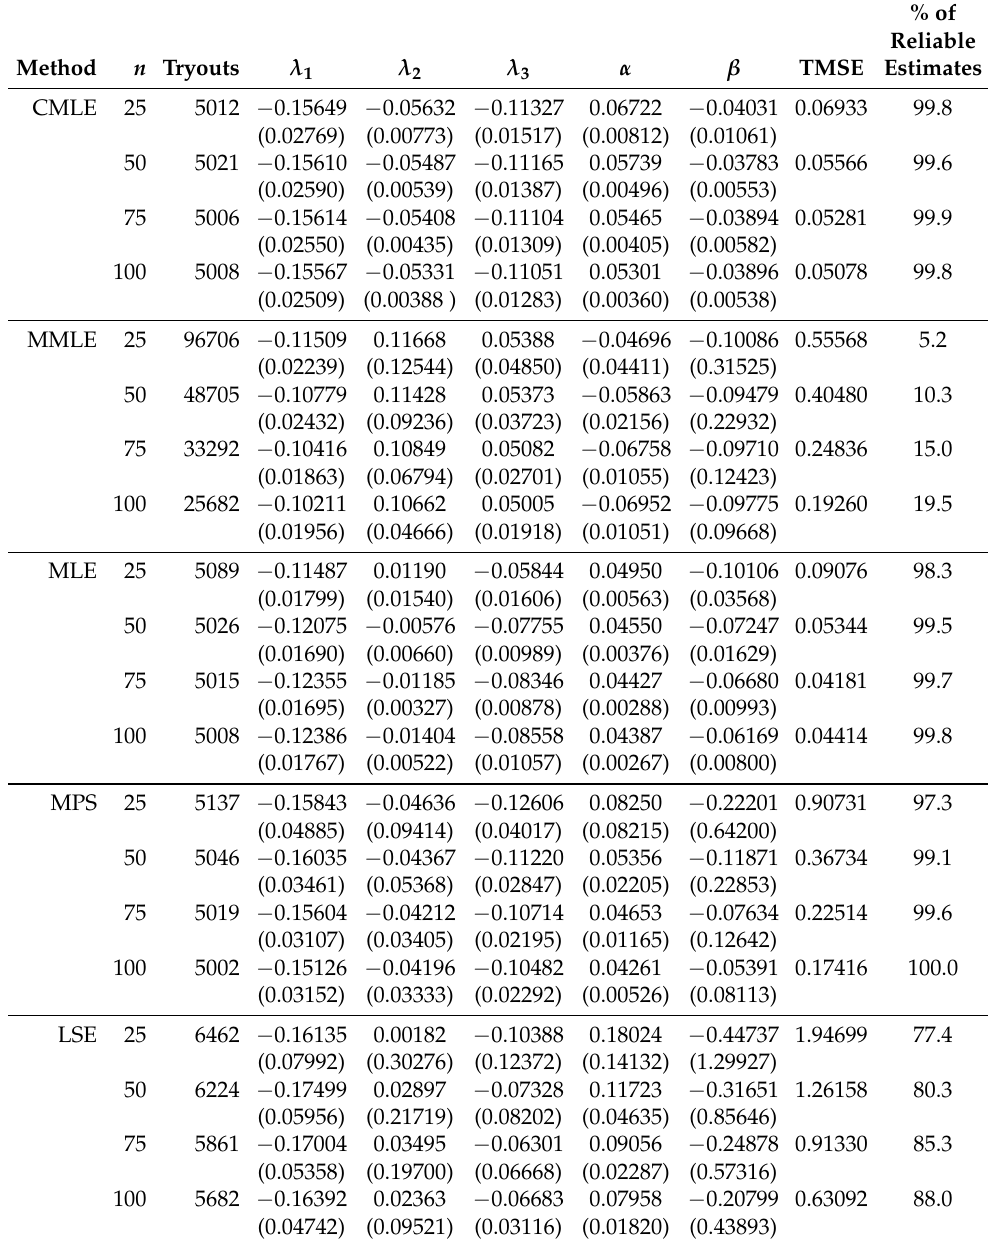
Table 4. Simulated biases and MSEs (in parentheses) of the parameter estimates obtained based